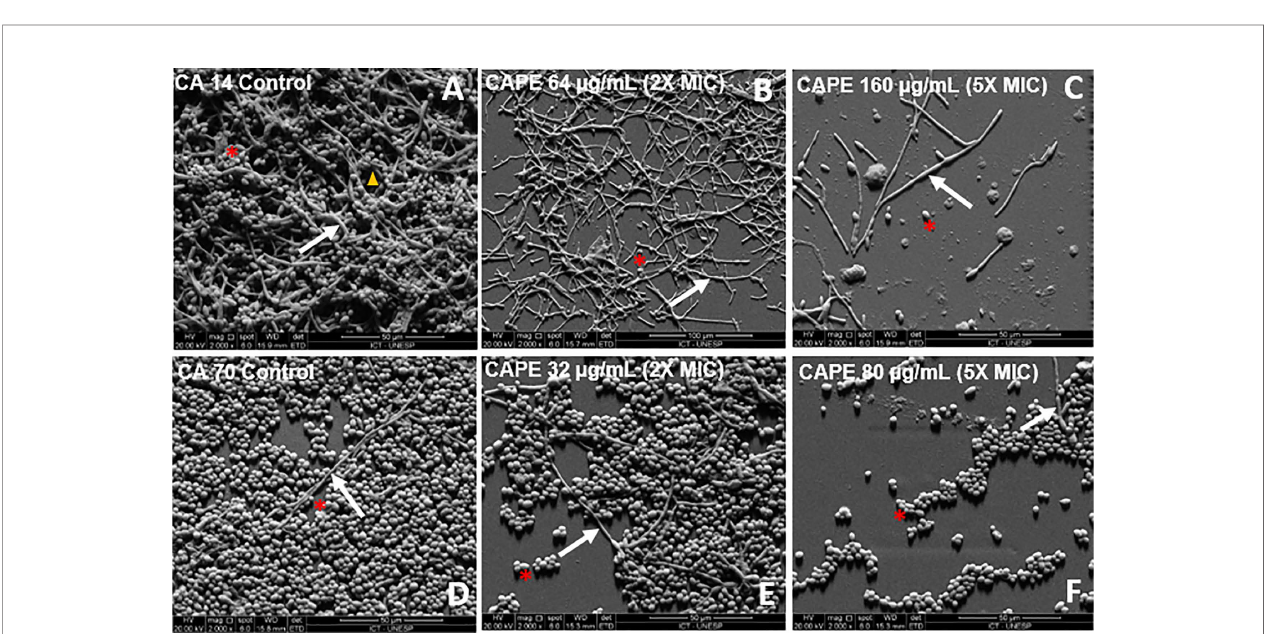
FIGURE 2 | (A – F) Scanning electron microscopy images of bio fi lms formed in vitro on resin surfaces, as follows: bio fi lms formed by only C. albicans (CA14) (A) and CA70 (D) , cells treated with CAPE (2 x MIC) (B, E) , cells treated with CAPE (5 x MIC) (C, F) . It is possible to observe the presence of channel water ( ! ), yeasts (*), and hyphae ( ▲ ) of C. albicans . Original magni fi cation